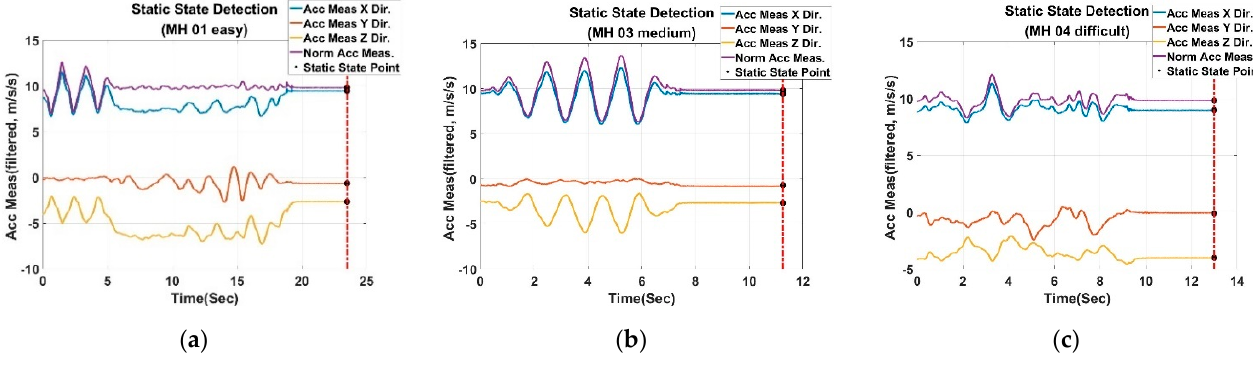
Figure 15. Filtered acceleration measurements and the results of static state detection: ( a ) For MH_01_easy series; ( b ) For MH_03_medium series; ( c ) For MH_04_difficult series.